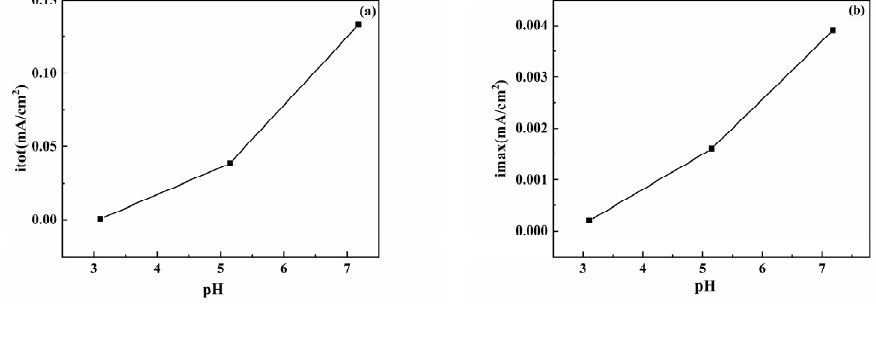
Figure 5. Bare electrode statistical and calculated results for ( a ) the sum of anode current density i tot , ( b ) the maximum anodic current density i max , ( c ) the localized corrosion intensity index L CII, and the number of anodes N A .